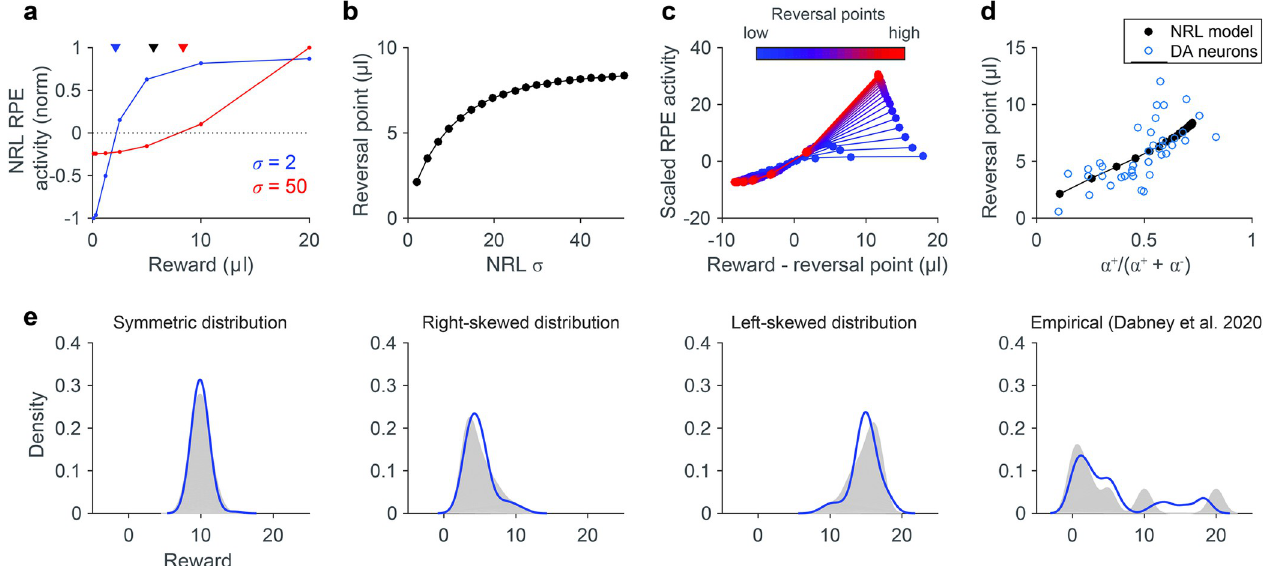
Fig 4. NRL RPE asymmetry provides a computational basis for distributional reinforcement learning. (a) Variable NRL RPE response asymmetries in a probabilistic reward environment. Examples show NRL agents with stronger negative (blue) and positive (red) RPE asymmetry. Note that these two agents exhibit different reversal points in the same reward environment (rewards = {0.1, 0.3, 1.2, 2.5, 5, 10, 20 μ l}, as in previous work [35]). Triangles denote the true average reward (black) and estimated average reward learned by pessimistic (blue) and optimistic (red) NRL agents. (b) Learned reversal points vary systematically with NRL parameterization. RPE responses and reversal points quantified for varying σ parameters. (c) Reversal points depend on NRL RPE asymmetry. Plots show NRL responses normalized by negative RPE slope and aligned to individual reversal points. As in empirical dopamine data, low (high) reversal points arise from stronger negative (positive) RPE asymmetry. (d) NRL asymmetry and learning match empirical dopamine data. Blue, dopamine neurons recorded in stochastic reward environment [35]; black, heterogeneous NRL agents in identical reward environment. Asymmetry is defined as in previous work as a function of positive ( α + ) and negative ( α - ) RPE coding slopes. (e) A population of NRL agents learns the distribution of experienced rewards. 40 NRL agents were simulated in four different reward environments: symmetric, right-skewed, left-skewed, and multimodal. Each panel plots the ground truth (gray) and decoded (blue) probability densities, with samples smoothed by kernel density estimation. Distribution decoding was performed via an imputation strategy, treating the NRL reversal points and response asymmetries as expectiles.